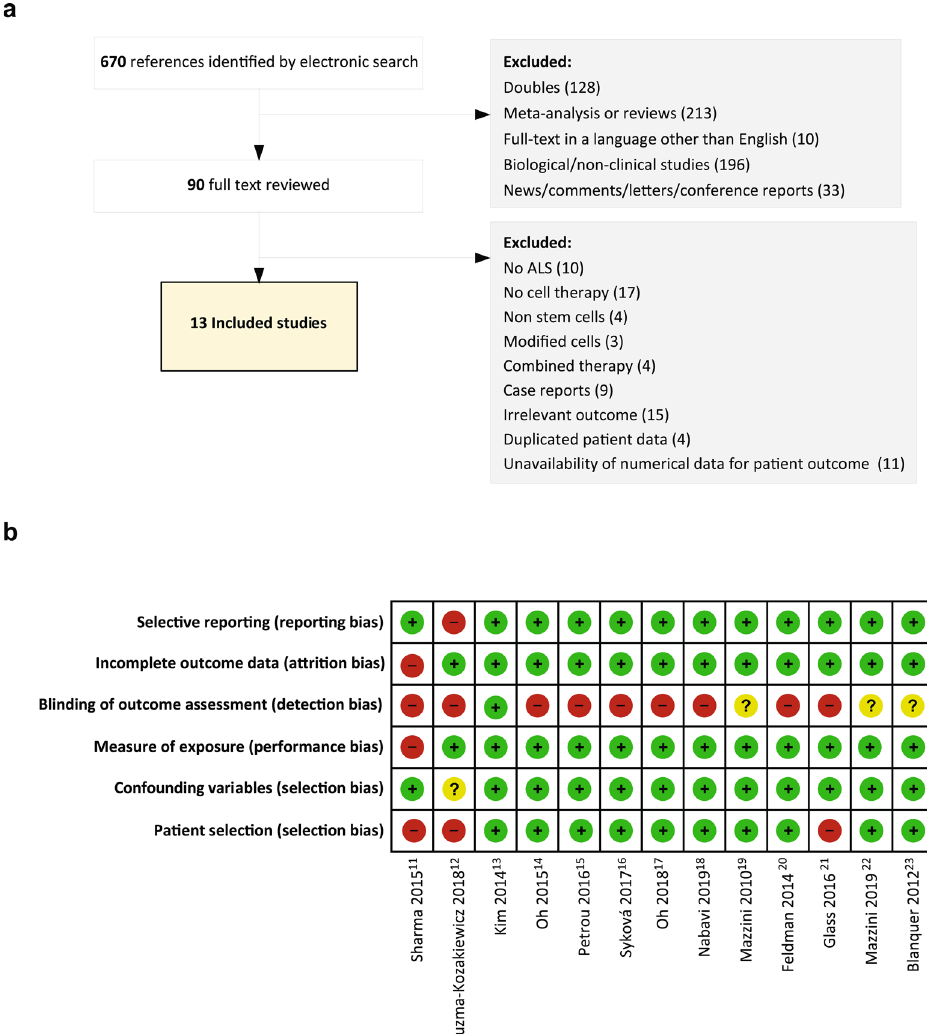
Fig. 1 Meta-analysis design. a Selection of studies. b Risk of bias summary: authors ’ judgment about each risk of bias item for the included studies. Red: high; yellow: unclear; green: low, according to RoBANS criteria 10